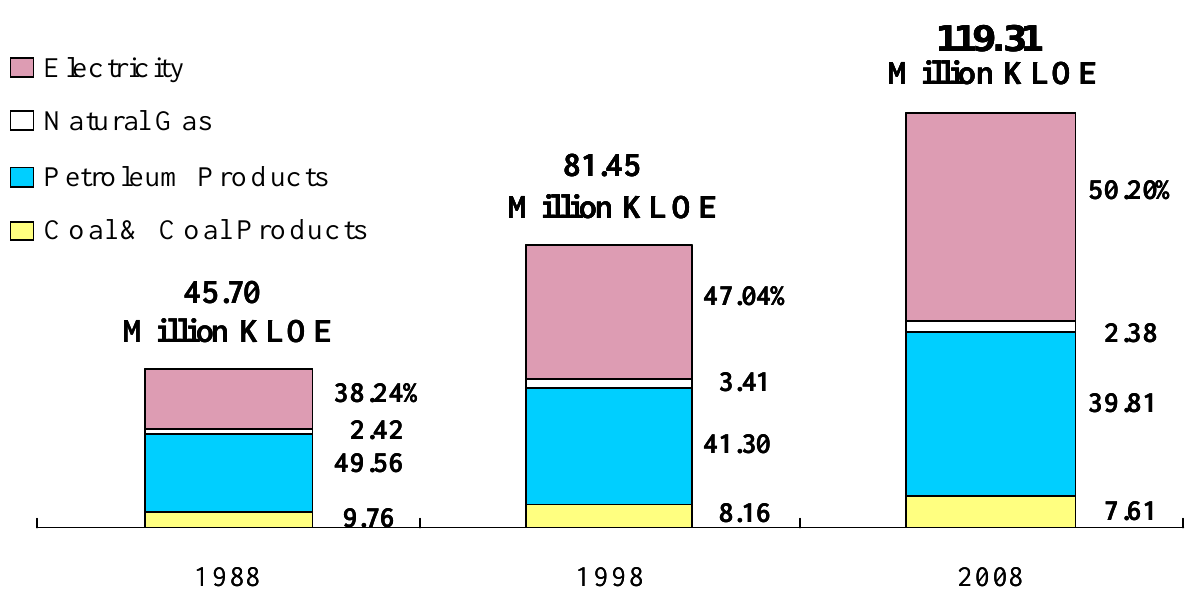
Figure 2. The structure of total energy consumption in Taiwan (by Energy Form)